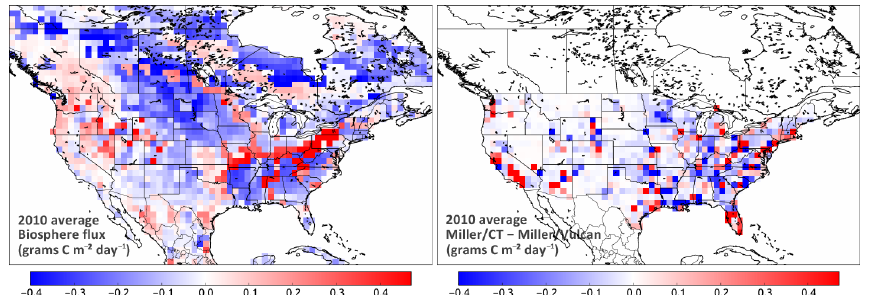
Figure 1. Comparative magnitudes of the annual average NEE estimated by CarbonTracker 2013B (left) and the difference between two fossil fuel inventories, Miller/CT and Miller/Vulcan (right). CarbonTracker is an atmospheric inversion which estimates CO 2 surface fluxes given atmospheric CO 2 measurements and “perfectly known” fossil fuel emissions. Miller/CT is the fossil fuel emission map prescribed in CarbonTracker 2013B, while Miller/Vulcan is a redistribution of the Miller/CT annual total fossil fuel CO 2 emission over the conterminous United States according to the spatiotemporal pattern of the Vulcan fossil fuel inventory (Gurney et al., 2009). While annual total emissions over the conterminous US for the two inventories are the same (i.e., the reds and blues in the right figure sum to zero), over individual 1 ◦ × 1 ◦ grid cells their difference can be comparable to the NEE estimated at the same